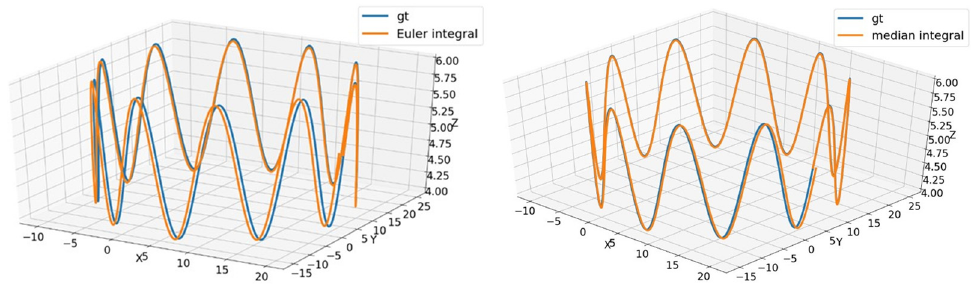
Figure 3. The comparison of Euler’s method ( left ) and median method ( right ).